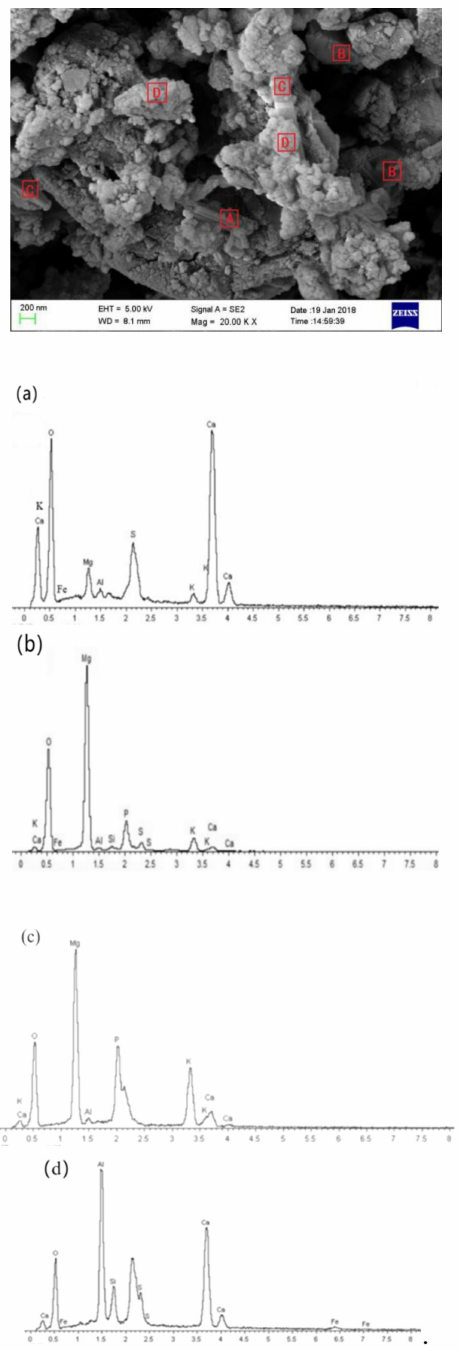
Figure 10. SEM micrographs of SAC-MKPC and EDS spectra (curing age: 28 days) ( a . A area, b . B area, c . C area, d . D